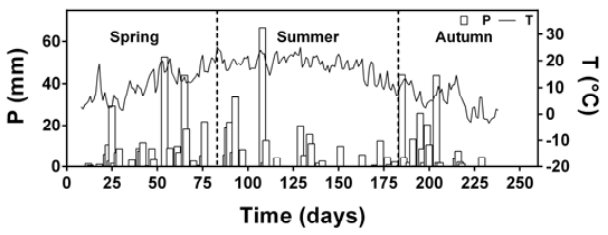
Figure 7. Precipitation and temperature from spring to autumn 2012 (Station Jean Lesage, Quebec).